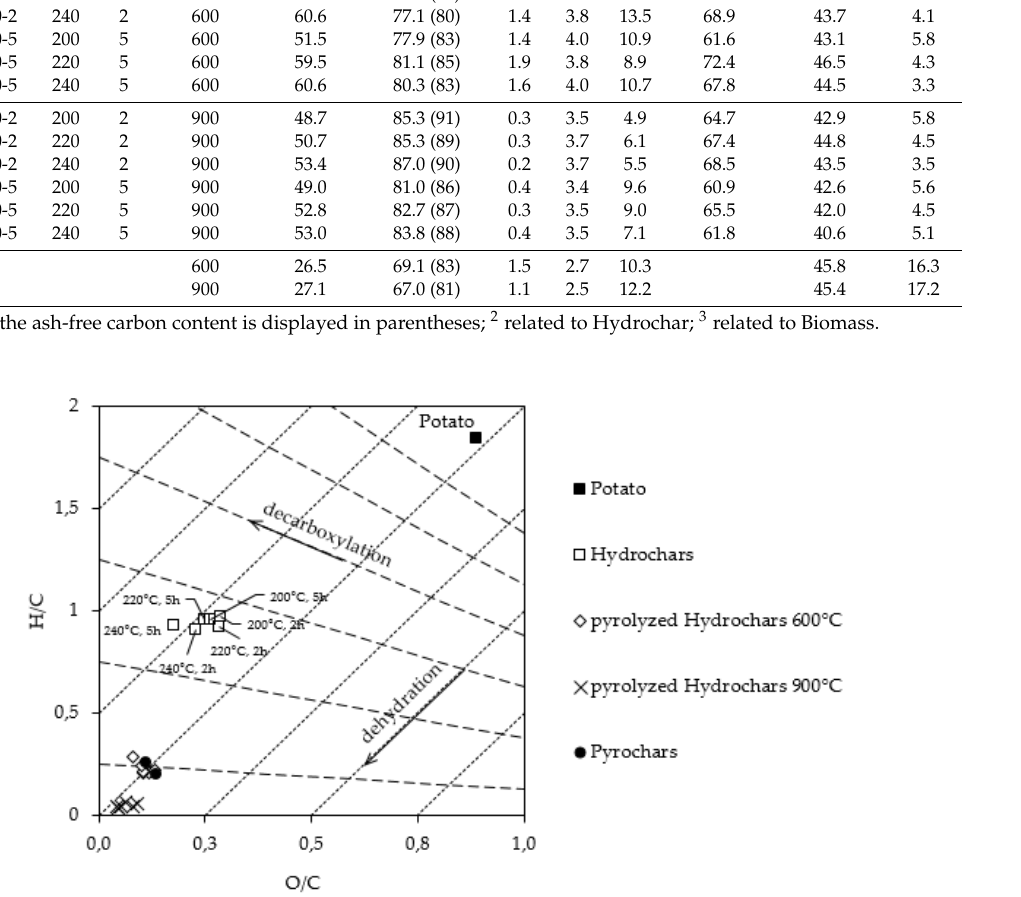
Figure 1. Van Krevelen diagram of the biomass and the